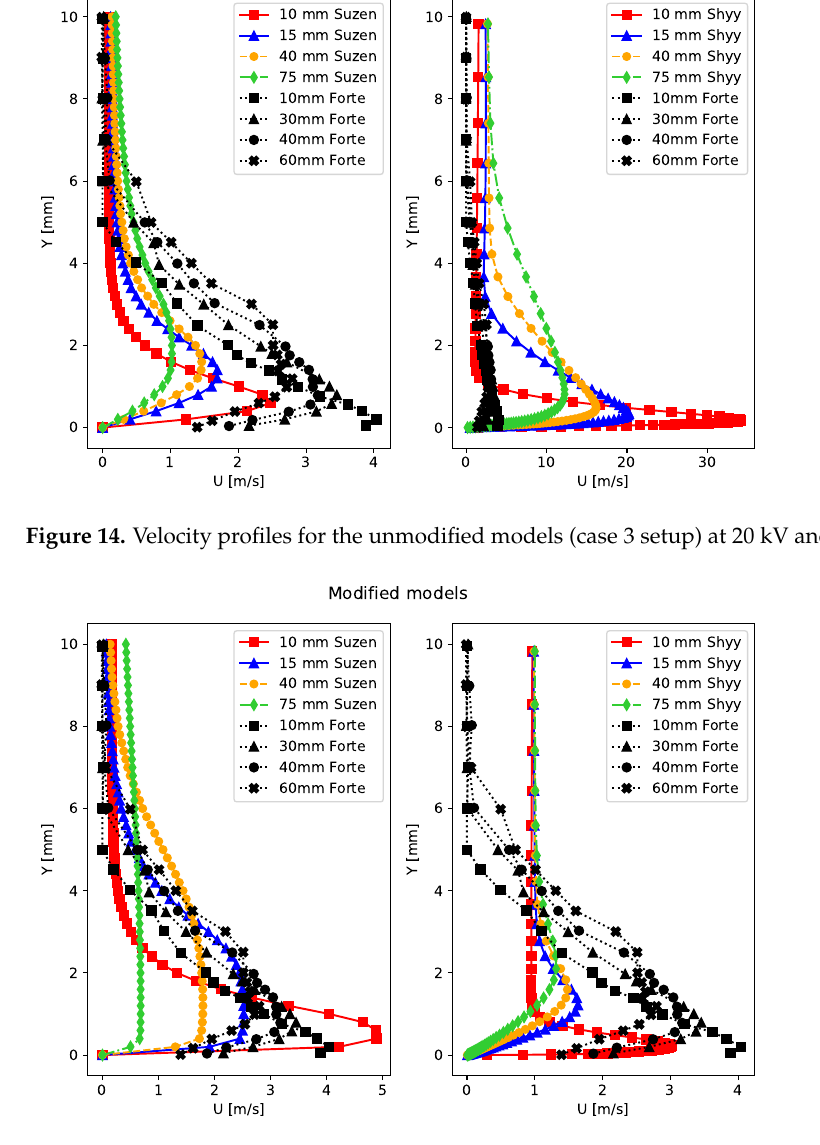
Figure 15. Velocity profiles for the modified models (case 3 setup) at 20 kV and 1